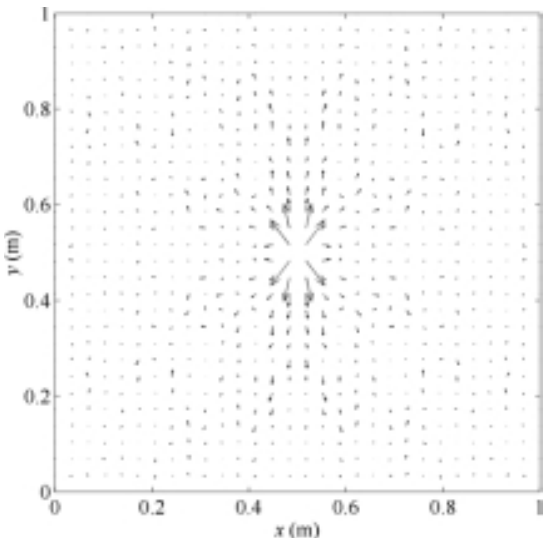
Fig.14. The approximate intensity field in the orthotropic plate when f = 5 kHz and η = 0 . 02